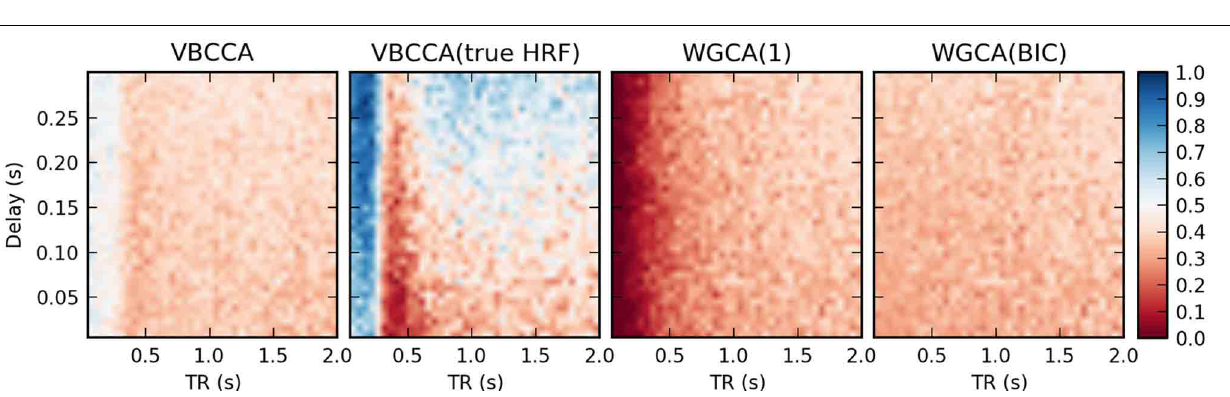
denoted VBCCA and we use P = 1, VBCCA(true HRF) denotes the proposed method with P = 1 and the HRF assumed in the algorithm is the same as the HRF that was used to generate the data. WGCA( P ) denotes the Wiener–Granger causality method, for which we use AR model orders of 1 and an order between 1 and 20 selected using the Bayesian information criterion